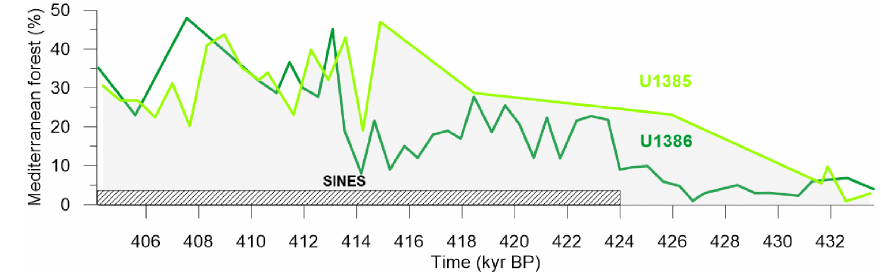
Figure 4. Comparison of Mediterranean forest (%) from sites U1386 (our study) and U1385 (by Oliveira et al., 2016), see